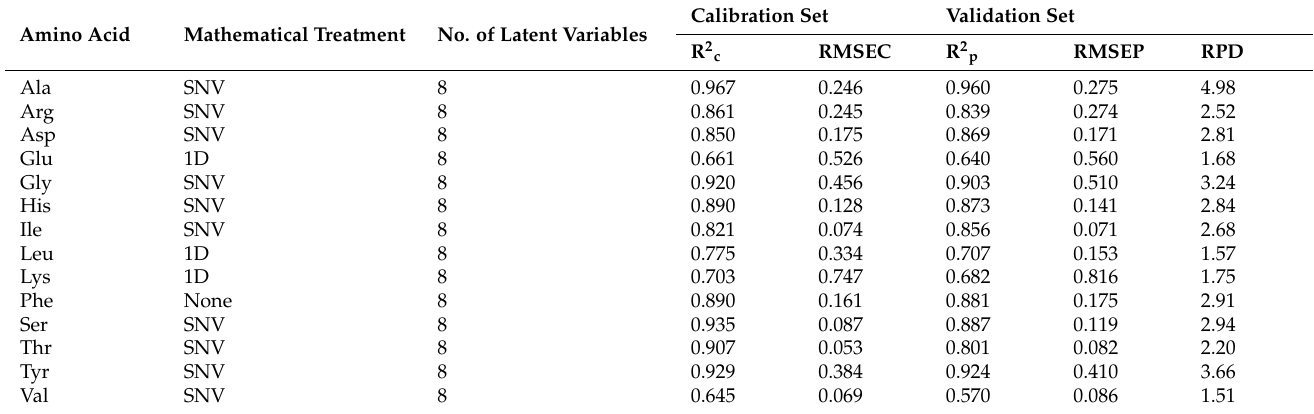
standard error of cross-validation of PLS calibrations. The best results were obtained with standard normal variate for most of the amino acid spectra except for glutamic acid, leucine and lysine, which required first-order derivation. Only phenylalanine did not require preprocessing to get the best results. Table 3. Statistics of NIR prediction models for amino acid content in living mealworm